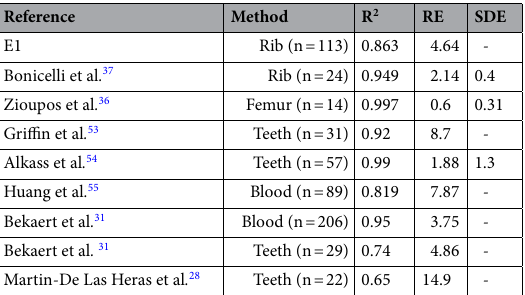
Table 3. Commonly used age-at-death methodologies. Comparison of accuracy and error of the estimation of the main laboratory-based approaches in age estimation (R 2 : coefficient of determination; RE: mean absolute residual error; SDE: standard deviation of absolute residual